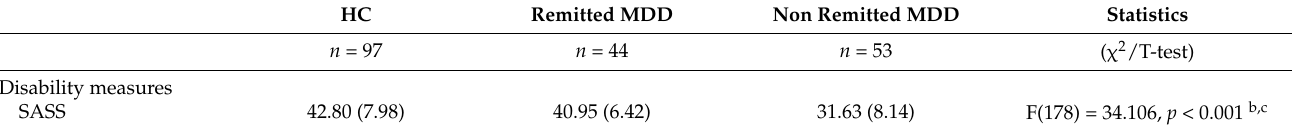
were no differences in gender between groups. HCs had undergone more education years than both MDD groups. BMI was significantly higher in non-remitted MDD compared than the other study groups. We found no significant differences between groups regarding the clinical variables of depression (age of onset; percentage of melancholic and atypical symptoms; number of depressive episodes and hospitalizations; suicide attempts) between remitted and non-remitted patients with MDD except for HDRS scores, which, as expected, were significantly higher in non-remitted patients. STAI (state and trait) scores were also significantly higher in non-remitted patients. HPA axis measures did not differ between groups except for evening cortisol levels, which was higher in non-remitted MDD patients than in HCs. Table 1. Disability, quality of life, and childhood maltreatment measures by study groups. HC Remitted MDD Non Remitted MDD Statistics n = 97 n = 44 n = 53 ( χ 2 /T-test) Disability measures SASS 42.80 (7.98) 40.95 (6.42) 31.63 (8.14) F(178) = 34.106, p < 0.001 b,c